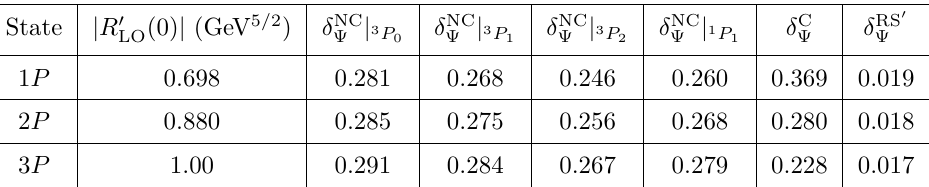
is Ψ is the Coulombic correction, and δ RS 0 is the Ψ Ψ , δ C , and δ RS 0 are Ψ Ψ Ψ